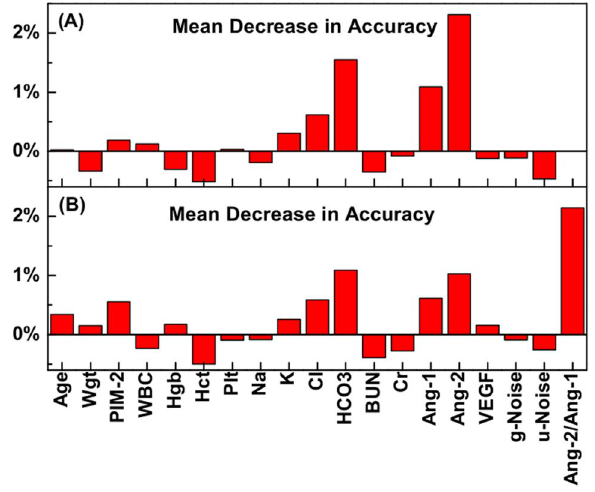
Figure 4. Longitudinal measurements of the sepsis severity score. The sepsis severity scores (Score) for patients from the PICU/ sepsis group and the PICU severe sepsis during the 7 days of illness. Both the mean and individual severity scores are plotted.